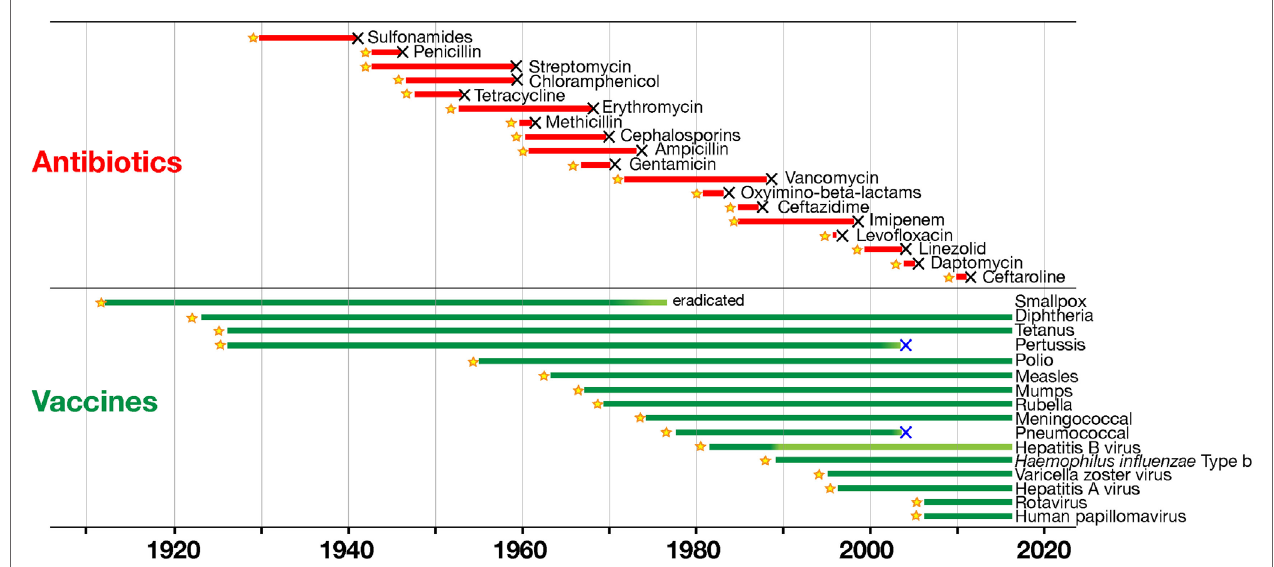
FiGuRe 1 | Time to detection of resistance of human pathogens to antimicrobials (in red) and to vaccines (in green). Black X symbols indicate insurgence of resistance, with lines starting at product introduction (yellow stars; except for smallpox vaccination that began much earlier; with modifications from Ref. (14) with the permission of the publisher).